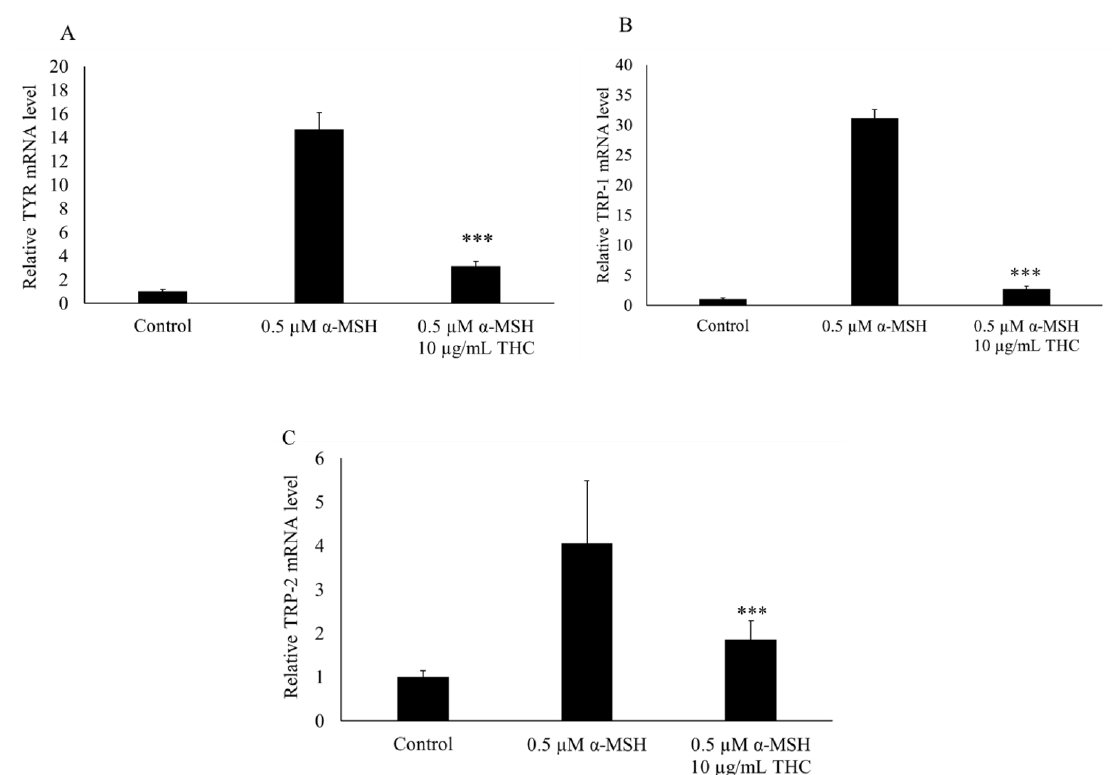
Figure 5. Effects of THC on mRNA expression of genes for TYR ( A ), TRP-1 ( B ), and TRP-2 ( C ) in B16F10 melanoma cells. Levels of mRNA were determined by PCR and GAPDH was used as the internal reference. Results are expressed as mean SD ( n = 3). *** p < 0.001 compared to group treated with α -MSH.